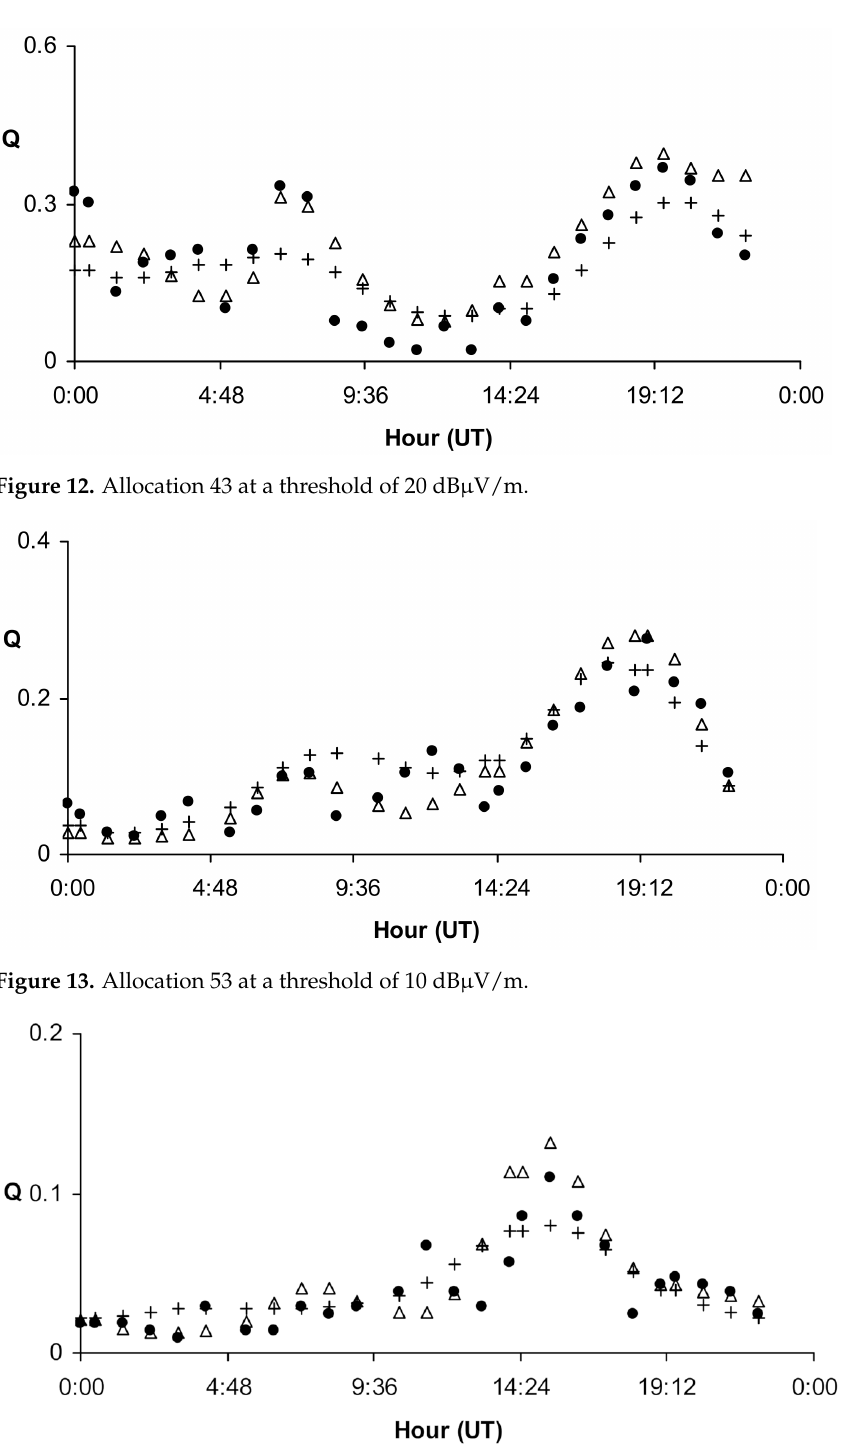
Figure 14. Allocation 72 at a threshold of 10 dB µ